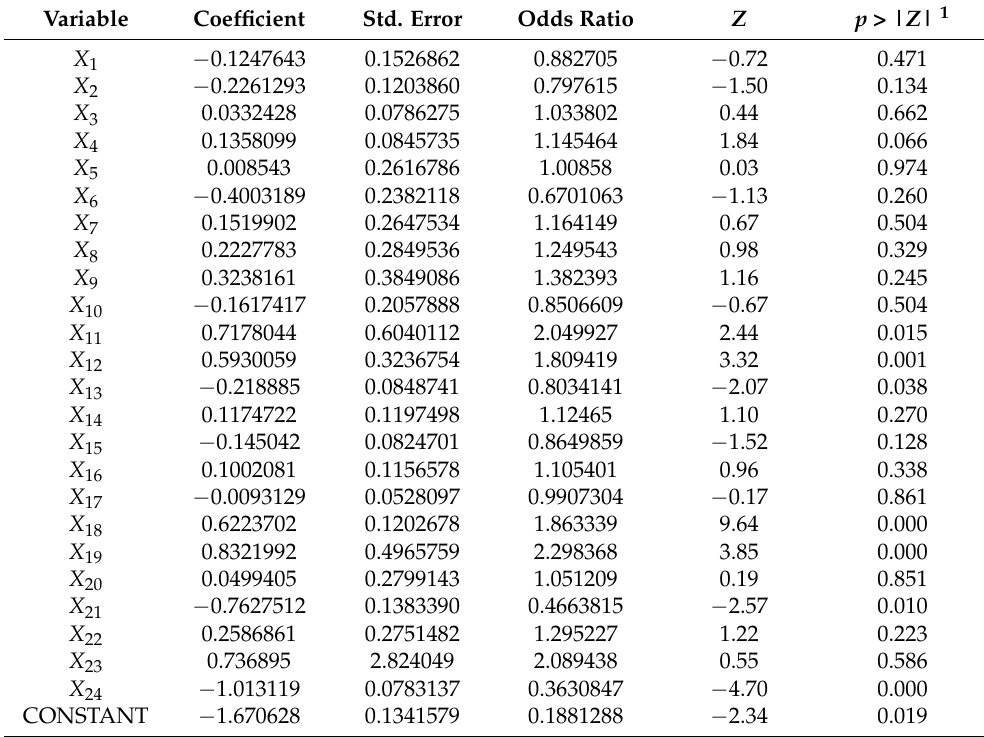
Table 6. Estimated coefficients and odds ratios for the logistic regression model containing 24 inde- pendent